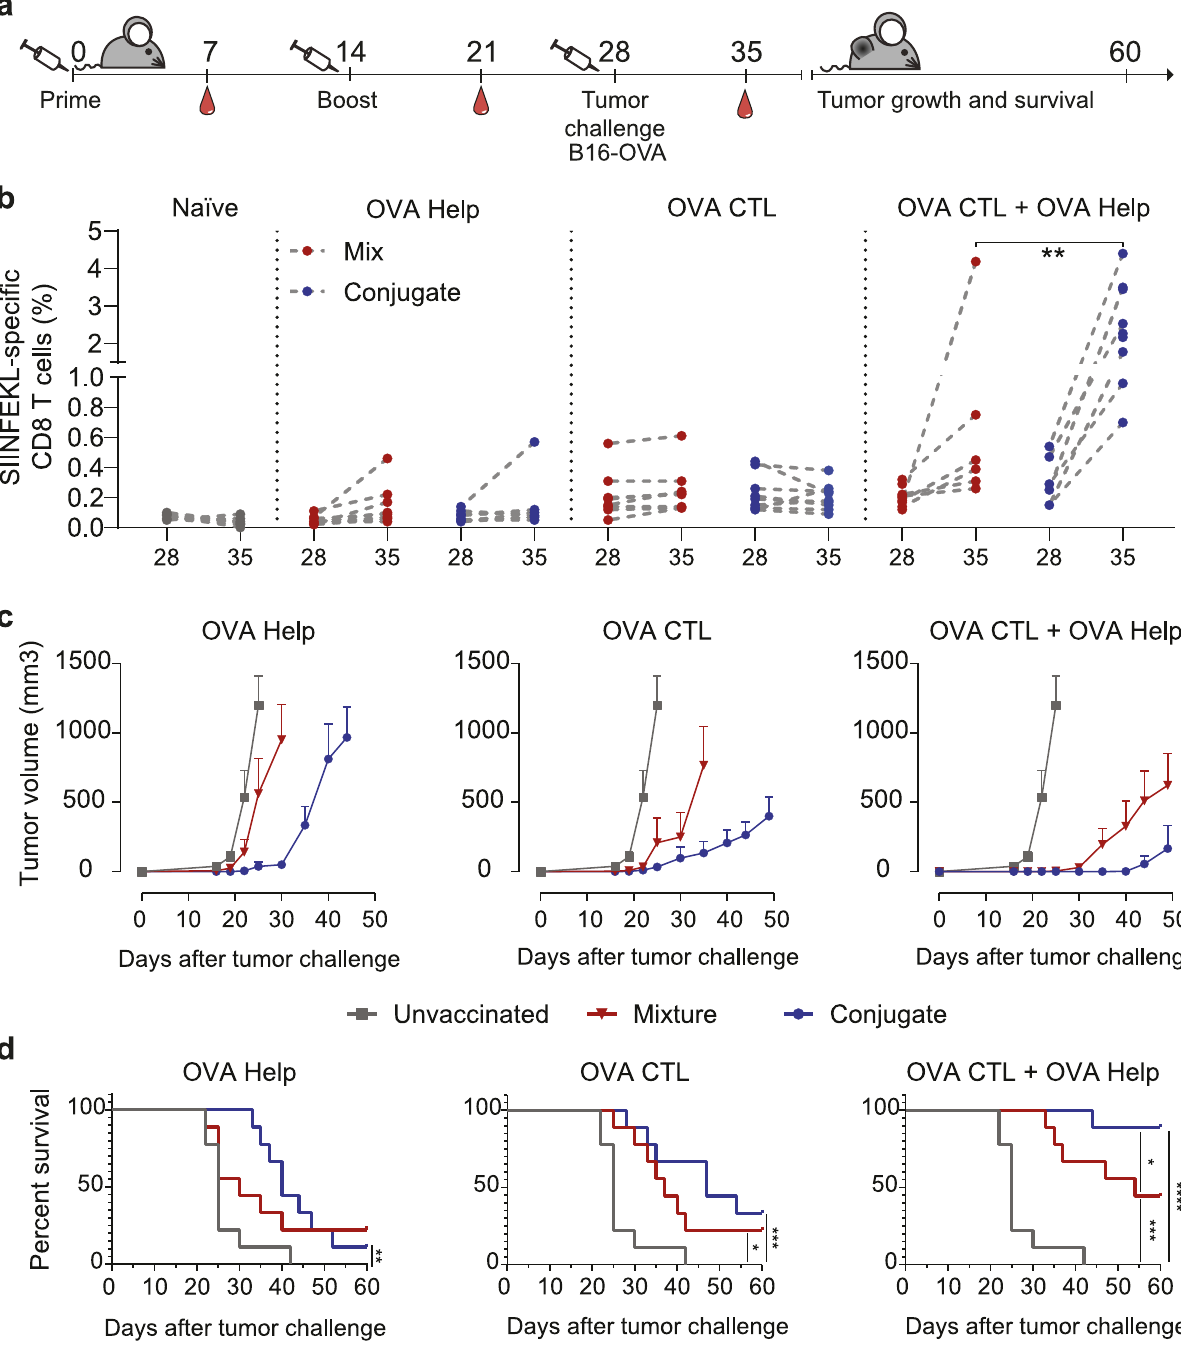
Fig. 4 Prophylactic vaccination with CRX-527-peptide conjugates potentiates tumor protection compared to unconjugated vaccines. a Schematic overview of the experiment. Mice ( n = 9) were primed and boosted at an interval of 2 weeks and later challenged with 100,000 B16OVA tumor cells. At the indicated time points, blood was withdrawn to analyze SIINFEKL-speci fi c CD8 responses by tetramer staining. b Frequencies of SIINFEKL-speci fi c CD8 T cell responses in all vaccinated and unvaccinated groups on the day of B16-OVA challenge and 7 days later. c Average B16-OVA tumor growth in groups that were unvaccinated (gray line) or vaccinated with either CRX-527 conjugate (blue line) or a mixture of CRX-527 and peptide (red line) containing OVA CTL or Helper epitopes. Data are displayed as mean ± SD. d Overall survival of prophylactically vaccinated mice with the indicated epitopes in form of CRX-527 conjugates or mixture. Statistical signi fi cance was determined by Log-rank Mantel – Cox test; * p < 0.05, ** p < 0.01, *** p < 0.001, ***** p < vaccinated with both peptides showed the most effective and resulted in a signi fi cant increase of survival (Fig. 4d). The protection from tumor growth (Fig. 4c, right panel). The mixture groups that were vaccinated with the CTL epitope displayed a of the lipid A analog and peptides protected less ef fi ciently than more accentuated delay in tumor growth, which was stronger in the conjugated peptides, which resulted in long-term overall the mice vaccinated with the CRX-527 conjugate compared to survival of about 90% of animals (Fig. 4d). the mixture (Fig. 4c, middle panel). Finally, the groups that were